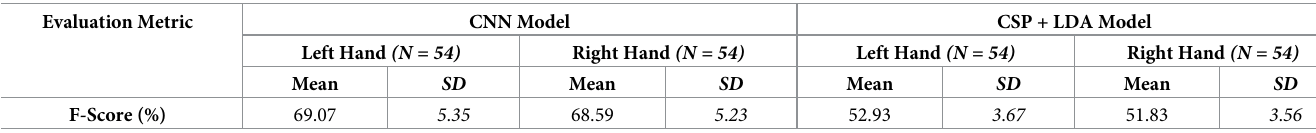
Table 2. Average F-score obtained by the CNN and CSP+LDA models for each MI class. Evaluation Metric CNN Model CSP + LDA